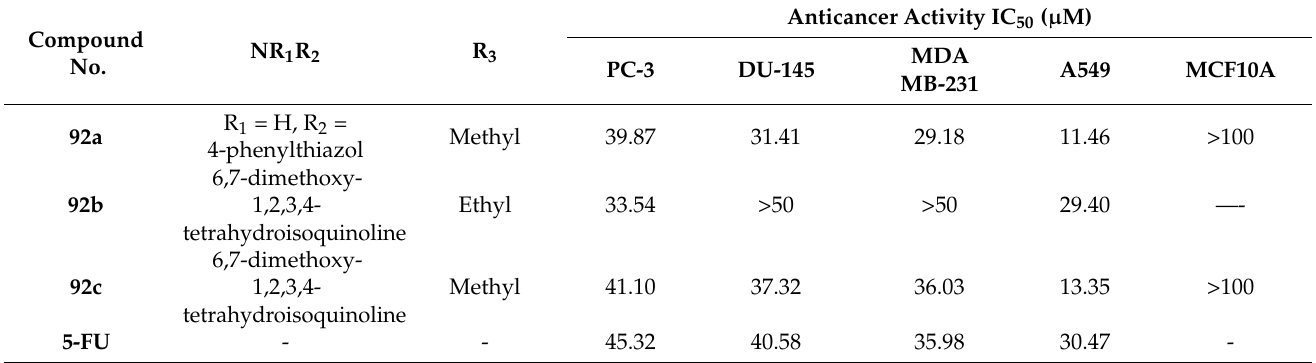
Table 78. In vitro cytotoxic activities of benzimidazole–thiazolidinedione hybrid compounds 92 ( a – c ).